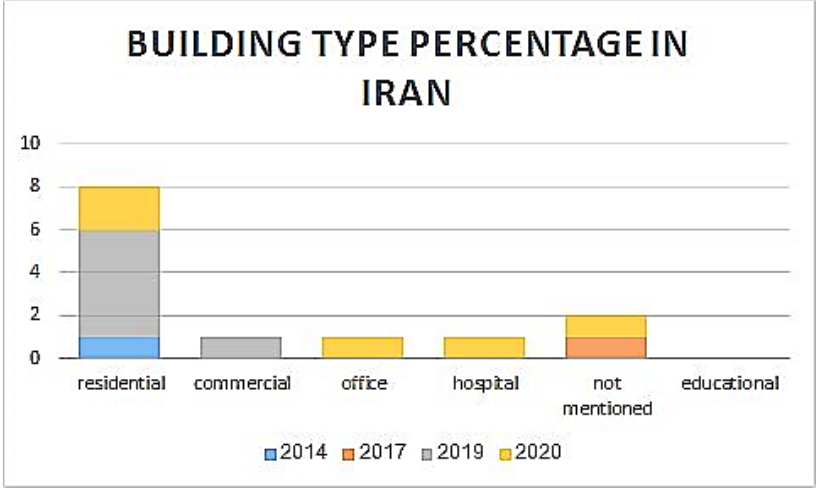
Figure 1. Building type percentages among case studies in Iran .